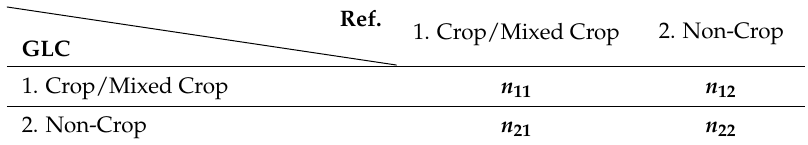
Table 2. Sample confusion matrix for two aggregated land cover types (i.e., GLC group 2). Ref. GLC